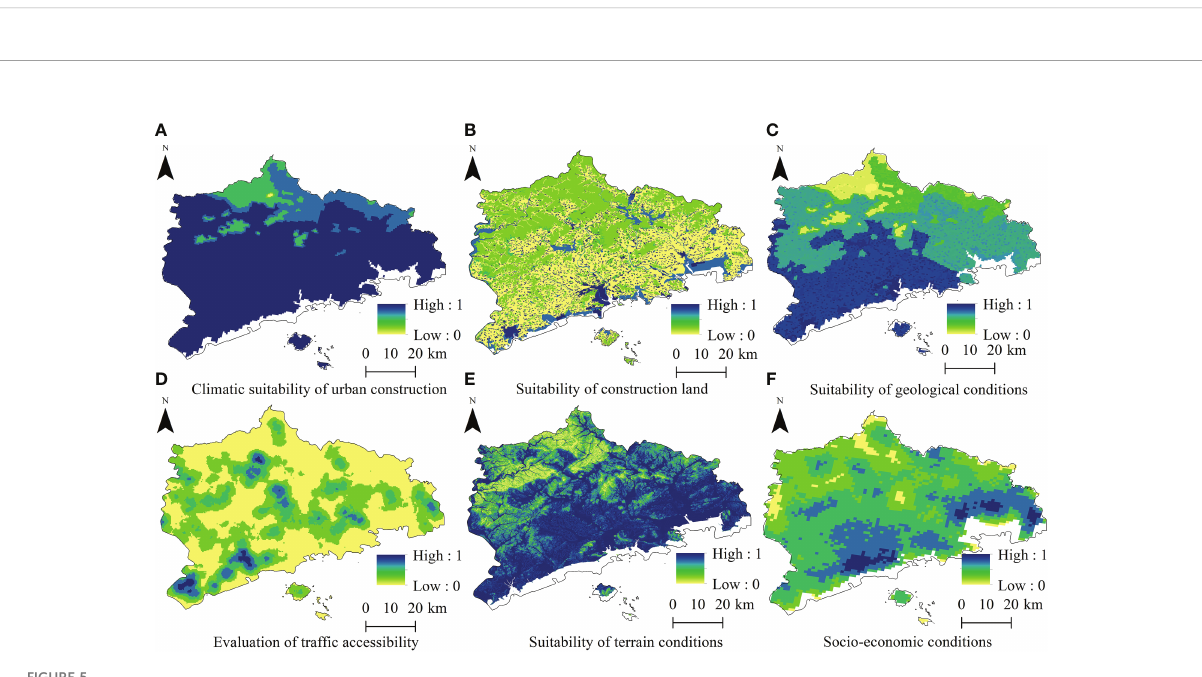
FIGURE 5 Evaluation of suitability factors for urban construction.